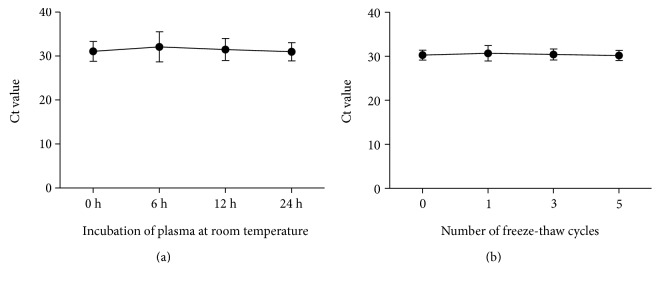
The stability of Linc00152 plasma in harsh environments. Incubation of plasma at room temperature (a) and the freeze-thawing processes (b).